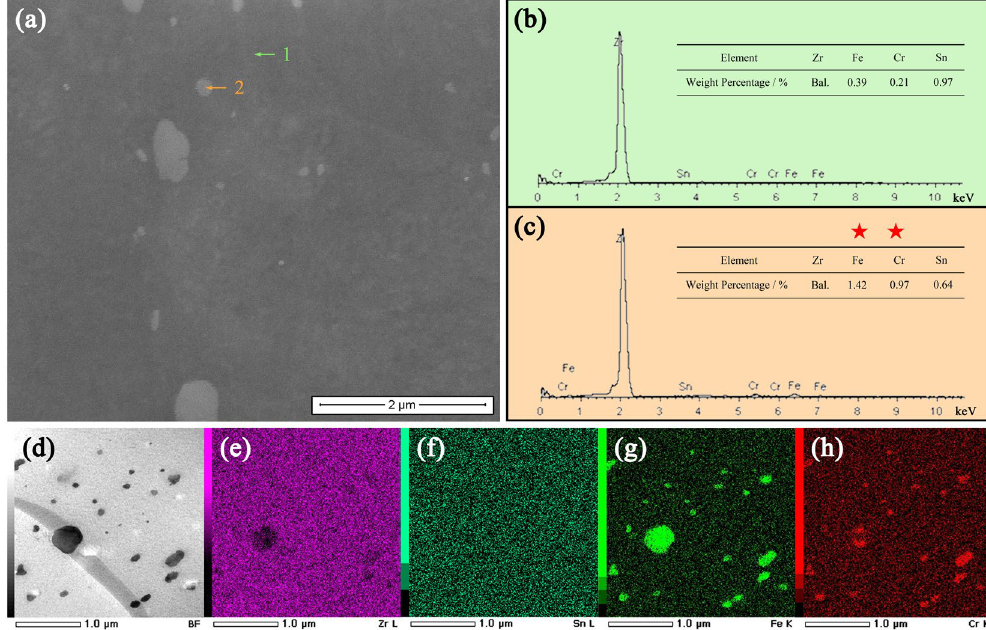
Figure 2. Compositional analysis. ( a ) The expanded surface morphology of the area outlined by a red square in Fig. 1j. ( b – c ) EDS spectra and compositions corresponding to Point 1 and 2 in Fig. 2a, respectively. ( d–h ) STEM image showing morphologies of precipitates (ball-shaped nanoparticles with dark contrast) in Zircaloy-4 ( d ) and its corresponding Zr L ( e ), Sn L ( f ), Fe K ( g ), and Cr K ( h ) elemental